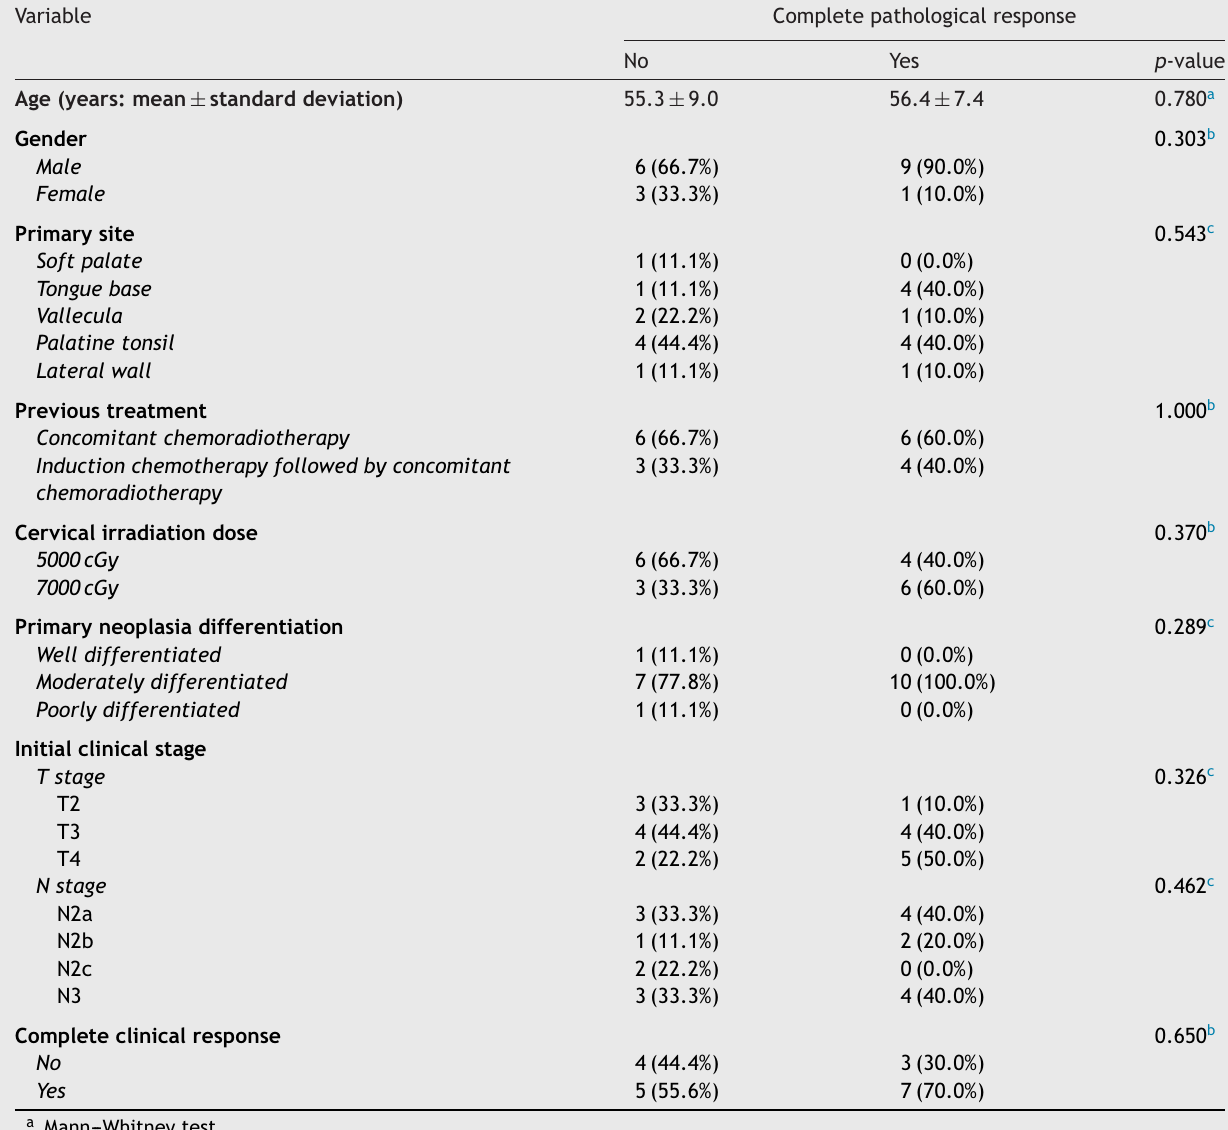
Table 2 Univariate analysis: variables associated with complete pathological response.